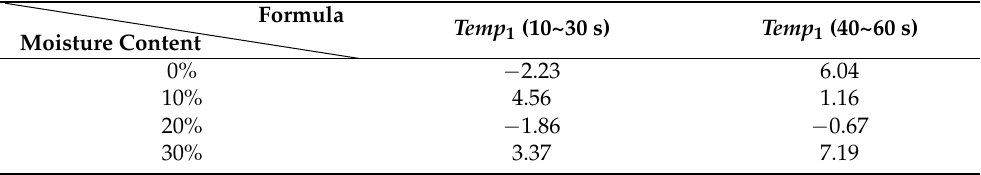
Table 4. Average difference in the soil surface temperature.